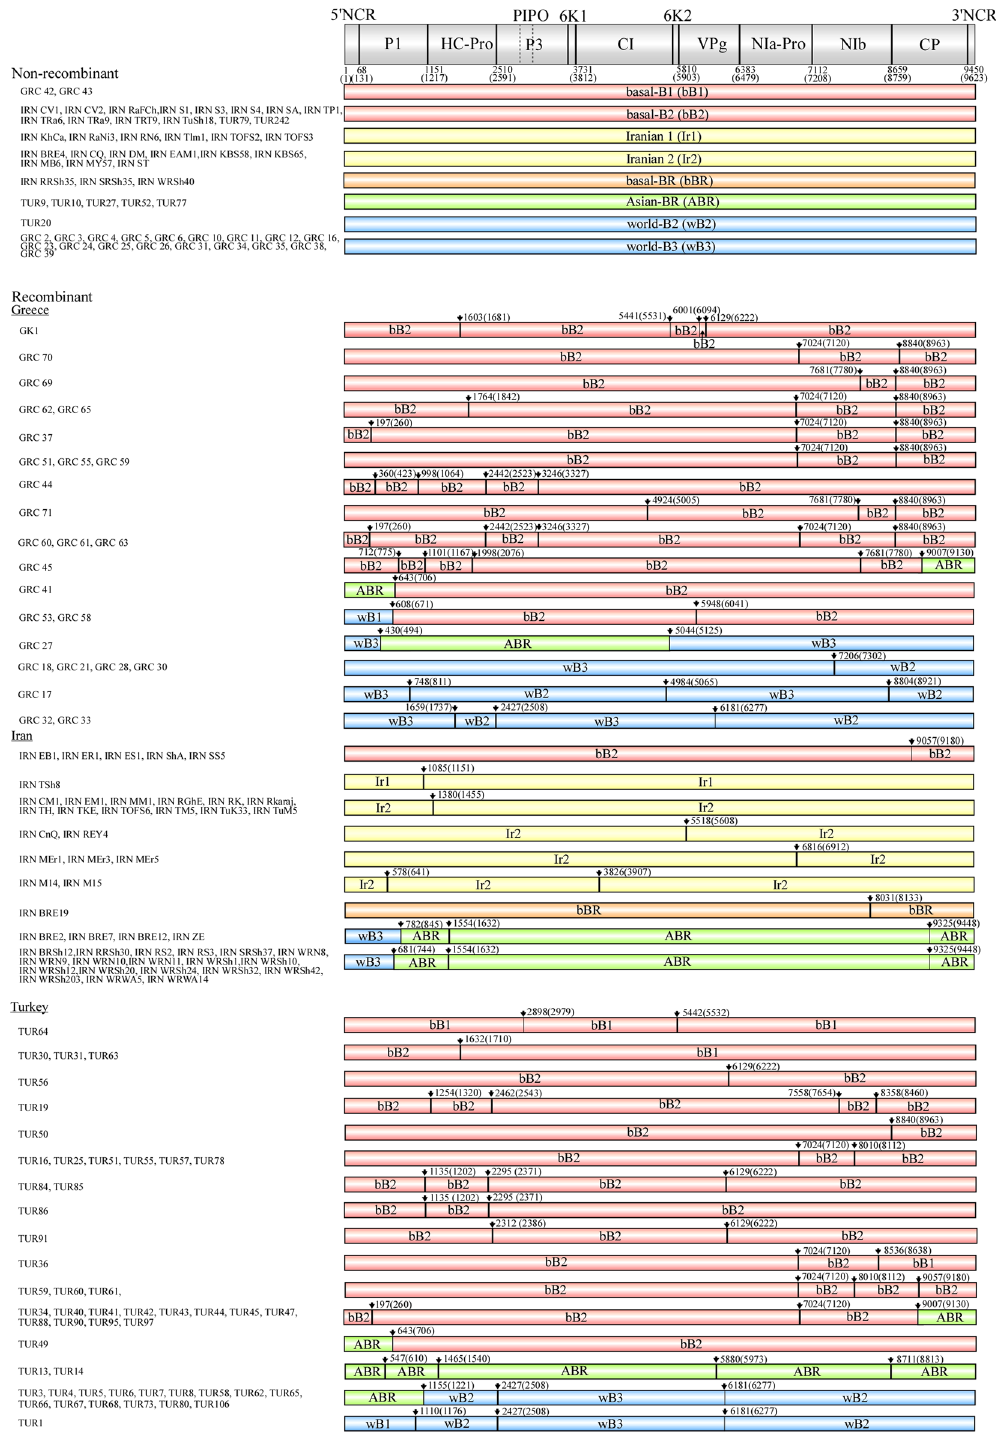
Figure 2. Recombination map of turnip mosaic virus genomes of the isolates from Greece, Iran and Turkey. The estimated nucleotide positions of the recombination sites and those in parentheses are shown relative to the 5 ′ end of the genome using the numbering of the aligned sequences used in the present study and the UK 1 isolate (Jenner et al . 57 ). Vertical arrows and lines show estimated recombination sites (listed in Supplementary Table S2). The clear (bold line) and tentative (thin line) recombination sites identified in the present study are listed